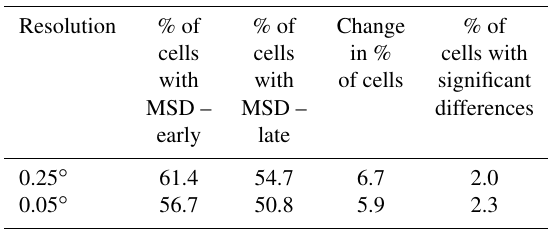
Table A1. Summary of percent of grid cells with MSD and the change between the early and late periods, based on the original MSD definition.